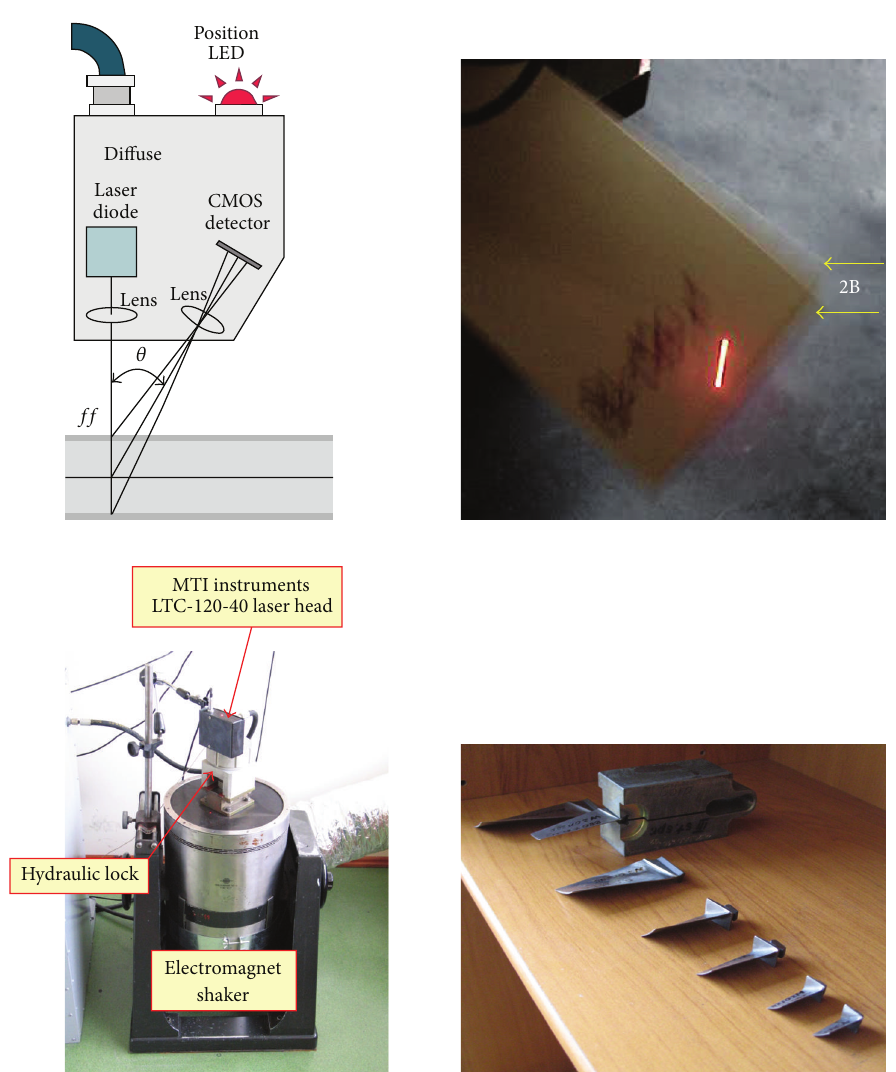
Figure 18: Workstation for the low-frequency (up to 4kHz) modal identification of the compressor blades. The tip timing observer (sensor) is built onto a fixed part of compressor. Its analog signal depends on the sensor type (Figure 19). Time period signal (time of blade arrival, TOA) would be measured with a frequency method or delay line (time-to digital converter) [3, 25, 96,